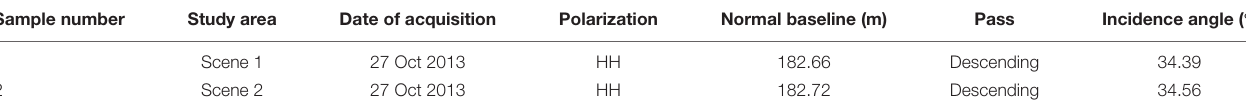
TABLE 1 | Details about the TDX data used for DEM